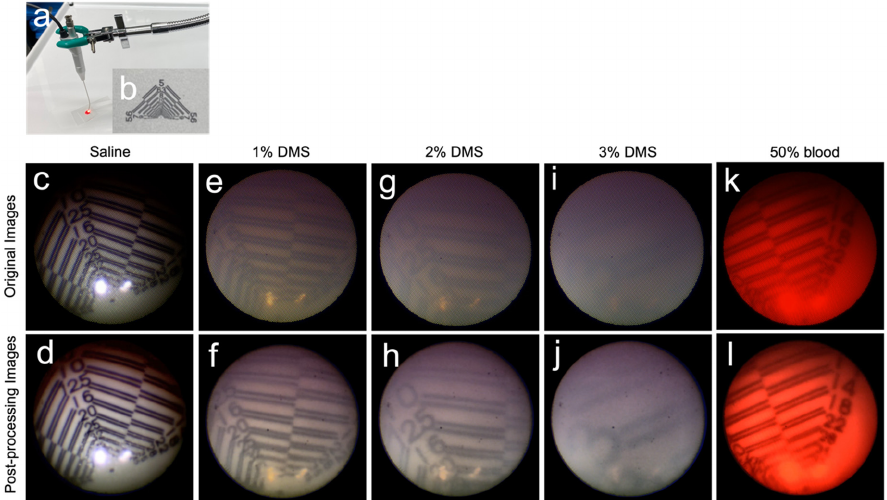
Figure 3. Settings and images of the in vitro experiment conducted to assess the effects of image processing on dacryoendoscopic images, whose quality deteriorated due to opacity caused by blood and pus in the lacrimal duct lumen. The test solution was placed on the test chart with a cover glass, and the endoscope was positioned such that the tip of its probe rested 1.5 mm above the test chart ( a , b ). Under saline, the original images ( c ) showed prominent comb artifacts. However, in the processed images ( d ), these comb artifacts were eliminated, and the visibility was improved. The image resolution of the original image was 25 line pairs/mm ( c ), whereas that of the processed image was 28 line pairs/mm ( d ). Images observed with 1%, 2%, and 3% diluted milk saline (DMS) showed an improved contrast and resolution after image processing. The resolutions of the original and post-processing images were as follows: (1) 1% DMS, 10 line pairs/mm ( e ) vs. 22 line pairs/mm ( f ); (2) 2% DMS: 10 line pairs/mm ( g ) vs. 16 line pairs/mm ( h ); and (3) 3% DMS: not evaluable ( i ) vs. 3 line pairs/mm ( j ). The resolution of the original and processed images in 50% blood was 18 line pairs/mm ( k , l )